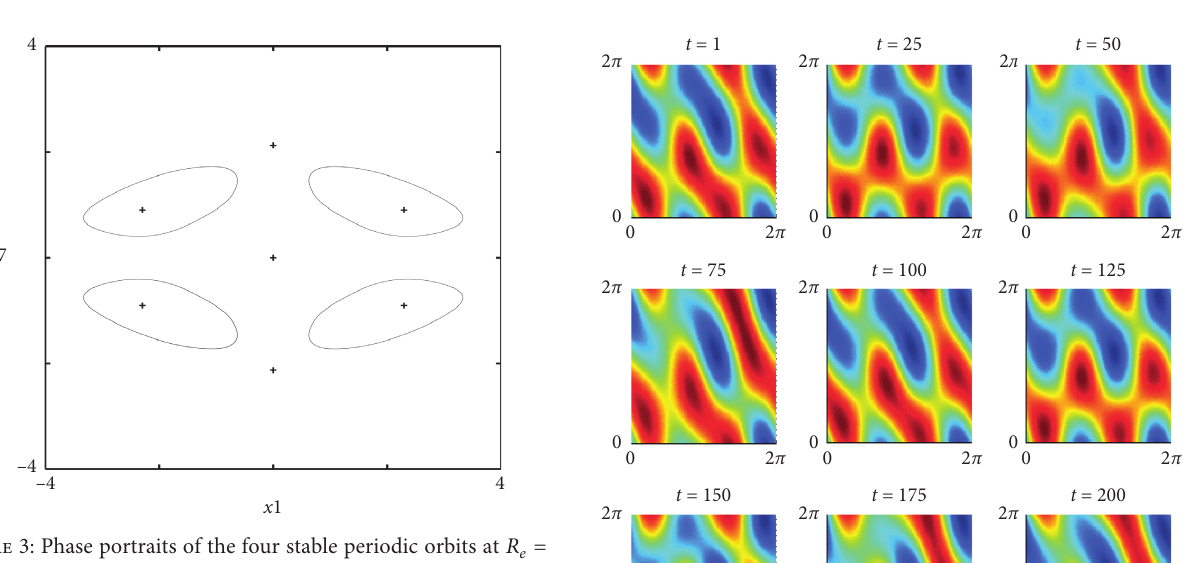
� ( 1 , − 0 . 5 , 0 . 7 , 2 . 5 , − 0 . 1 , 3 . 5 , − 0 . 4 ) ; (c) x T 0